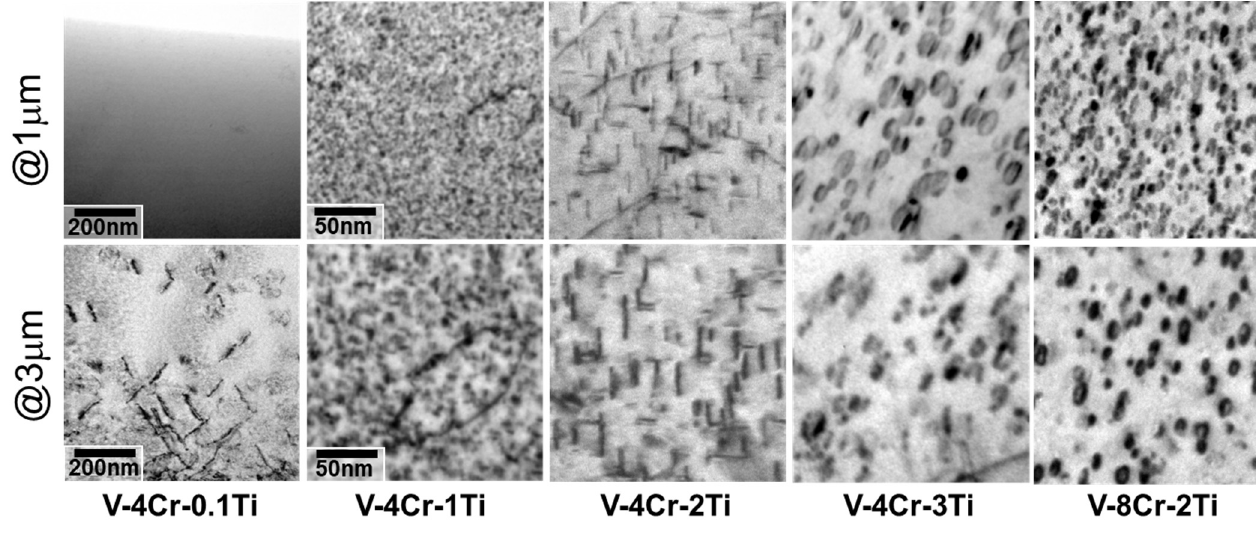
Figure 3. Bright-field TEM images of He-irradiated V–Cr–Ti(h) alloys at 500 °C. Upper parts show high-magnification images at a 1 μ m depth and lower parts show images at a 3 m depth. Note that the left photo has a different magnification than the other ones.